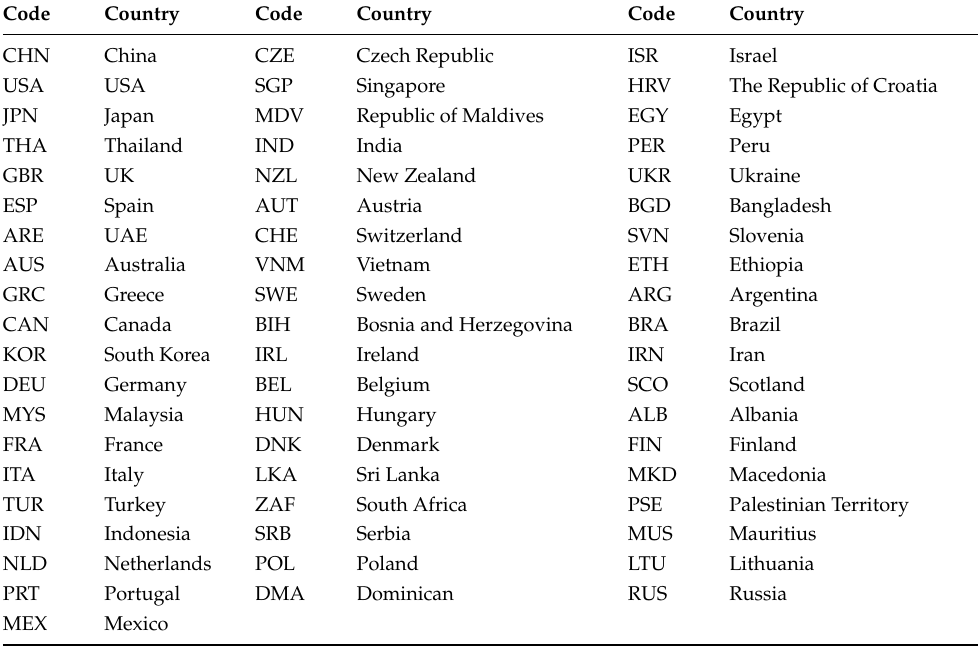
Table A4. The codes of the countries in which the conferences are